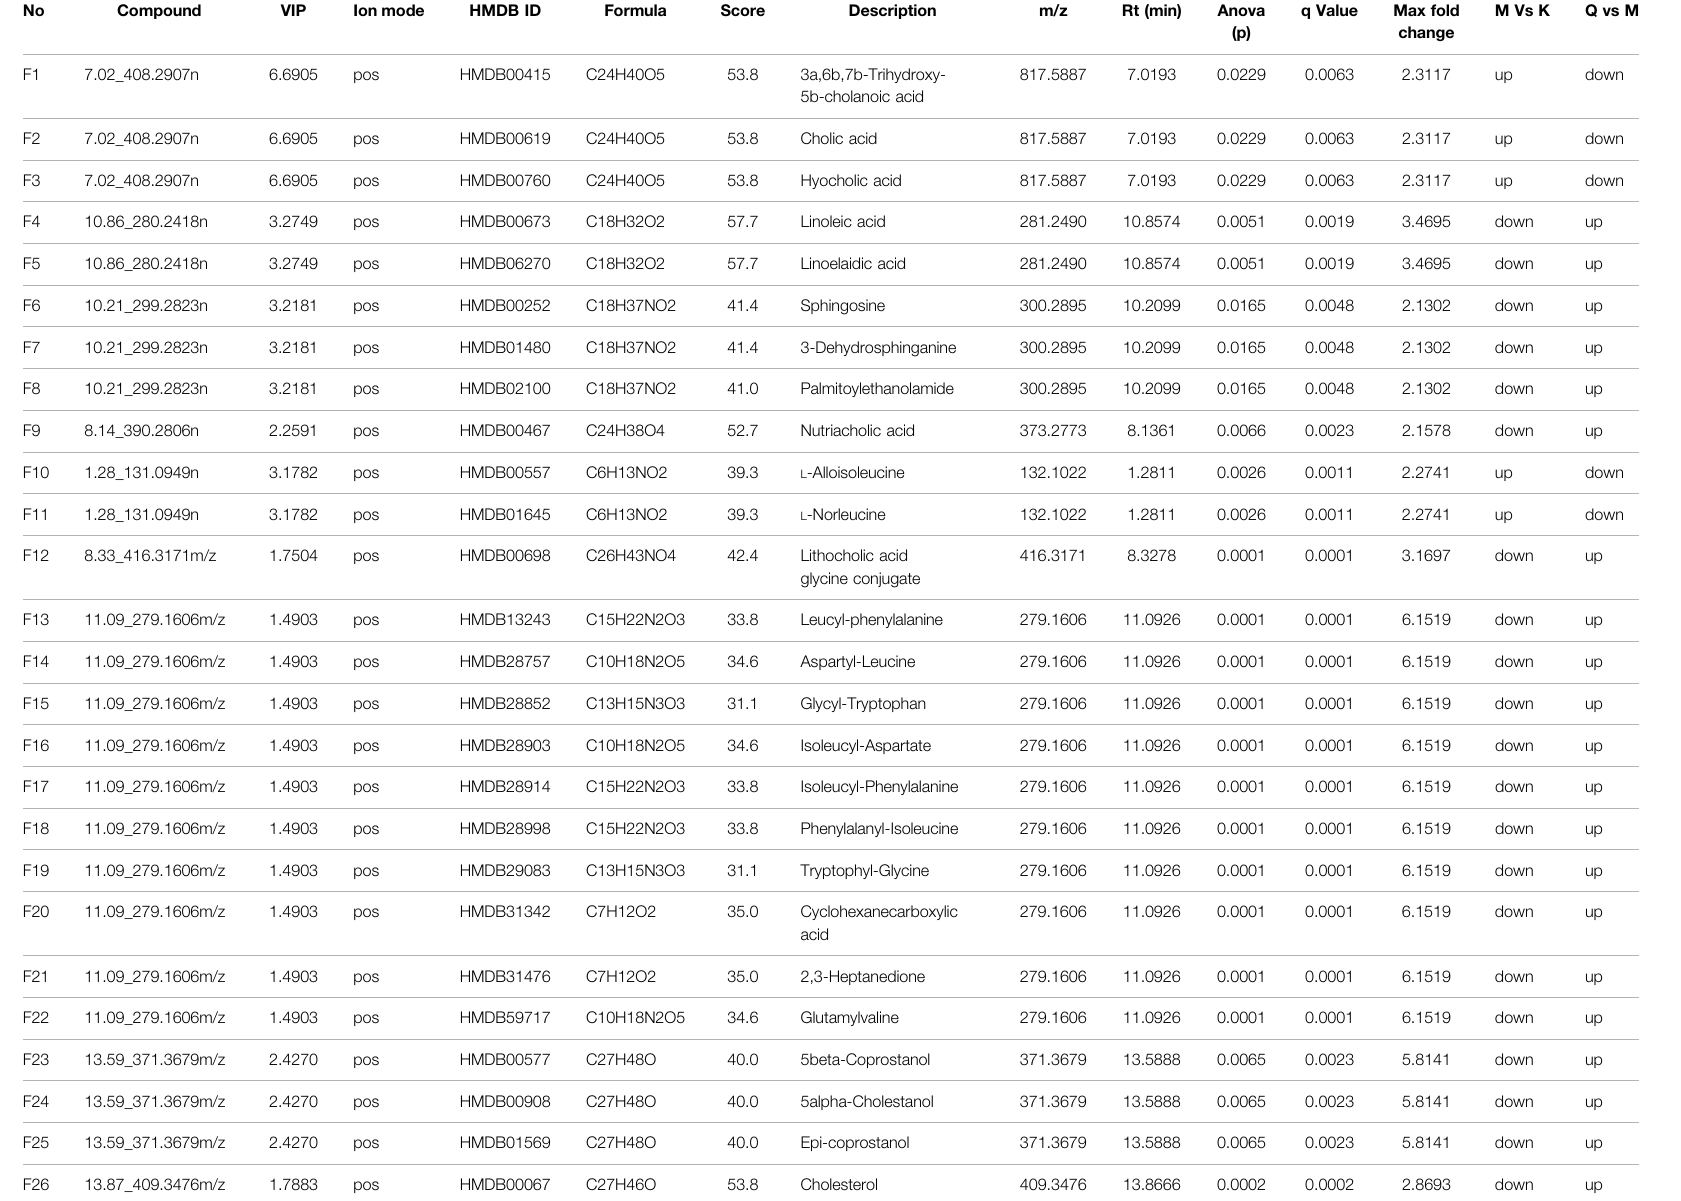
TABLE 2 | Signi fi cant differential metabolites produced in the faecal after the intervention of R. Scrophulariae in model